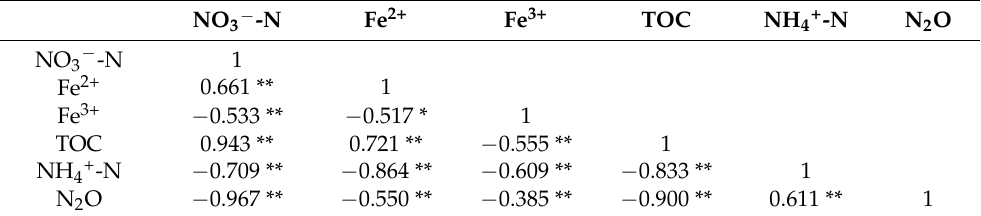
Table 2. Correlation matrix of the chemical properties in all soil samples. NO 3 − -N Fe 2+ Fe 3+ TOC NH 4+ -N N 2 O NO 3 − -N 1 Fe 2+ 0.661 ** Fe 3+ TOC 0.943 ** 0.721 ** NH 4+